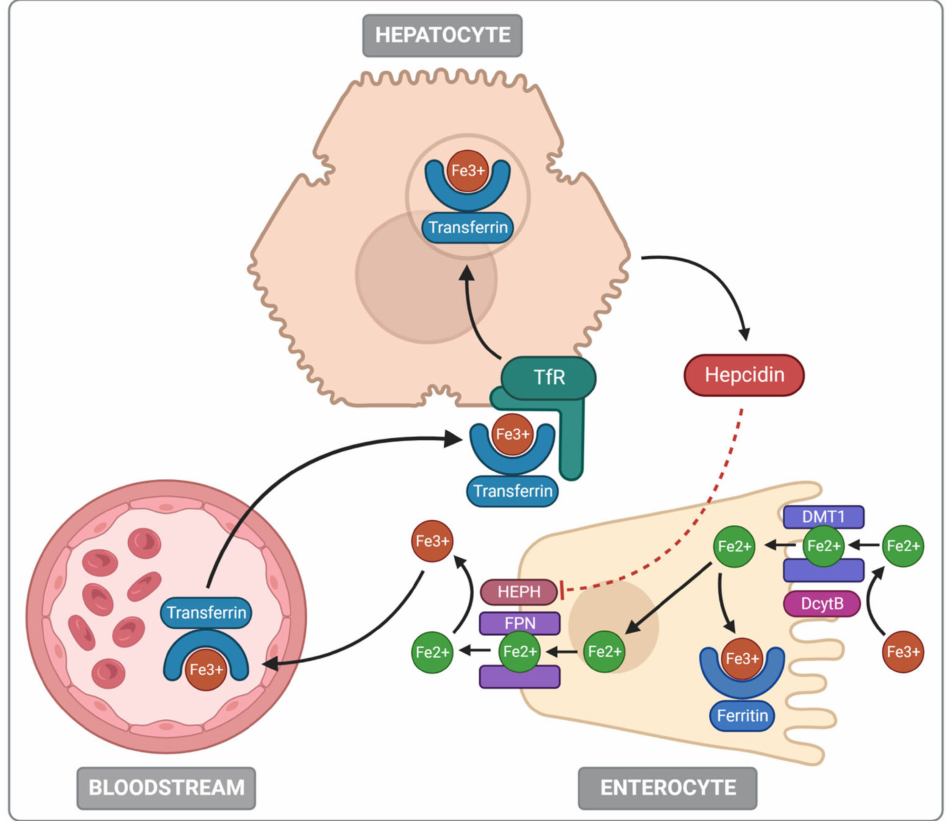
Figure 2. Iron metabolism. DcytB—duodenal cytochrome B; DMT1—divalent metal-ion transporter-1; FPN—ferroportin; HEPH—hephaestin; TfR—transferrin receptor; dashed